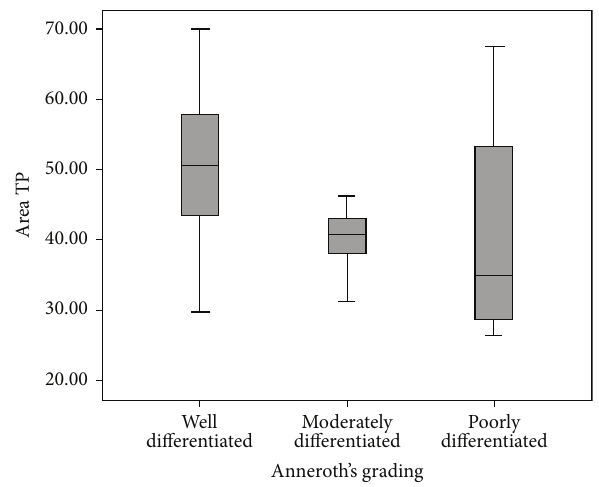
Figure 2: This graph depicts the relation of nuclear area at tumor proper with Anneroth et al. grading system in oral squamous cell carcinoma patients (graph depicted “tumour proper as TP”) ( 𝑛 = 32 ). The statistical significance was calculated using Chi-square test (value = 6.686) and statistical significance shown as ∗ 𝑃 = 0.035 .